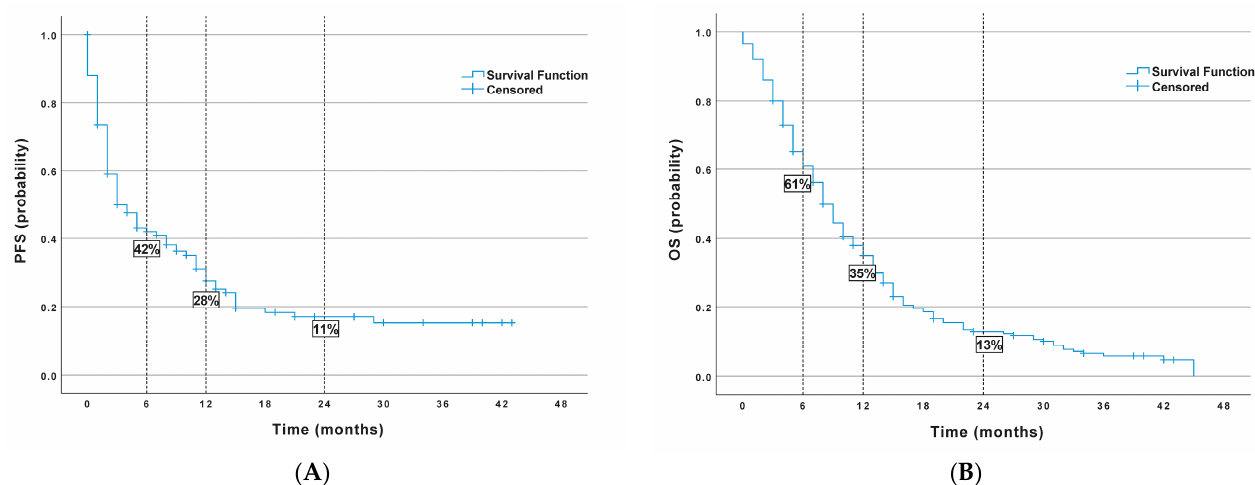
Figure 1. Probability of survival in the entire population ( A ) PFS (progression free survival), ( B ) OS (overall survival). (overall